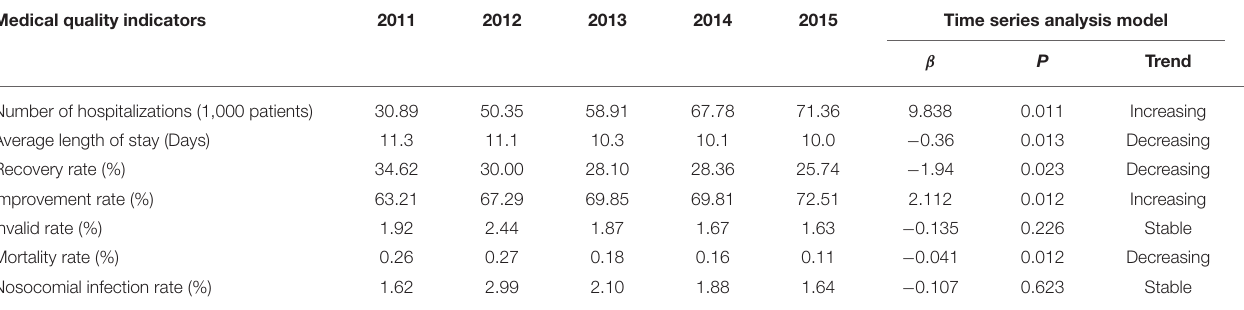
TABLE 2 | Annual medical quality indicators in the Changzhou No. 2 People’s Hospital,